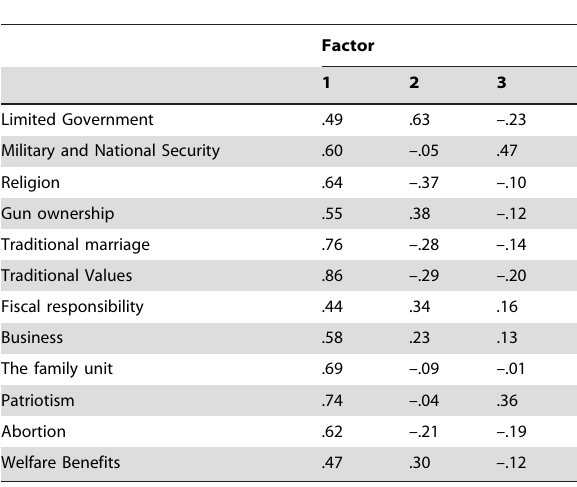
Table 3. Pattern Matrix using Principal Axis Factoring (PFA) and Direct Oblimin